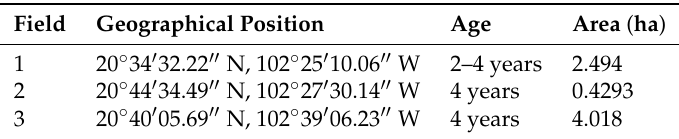
Table 1. Geographical position and area of studied